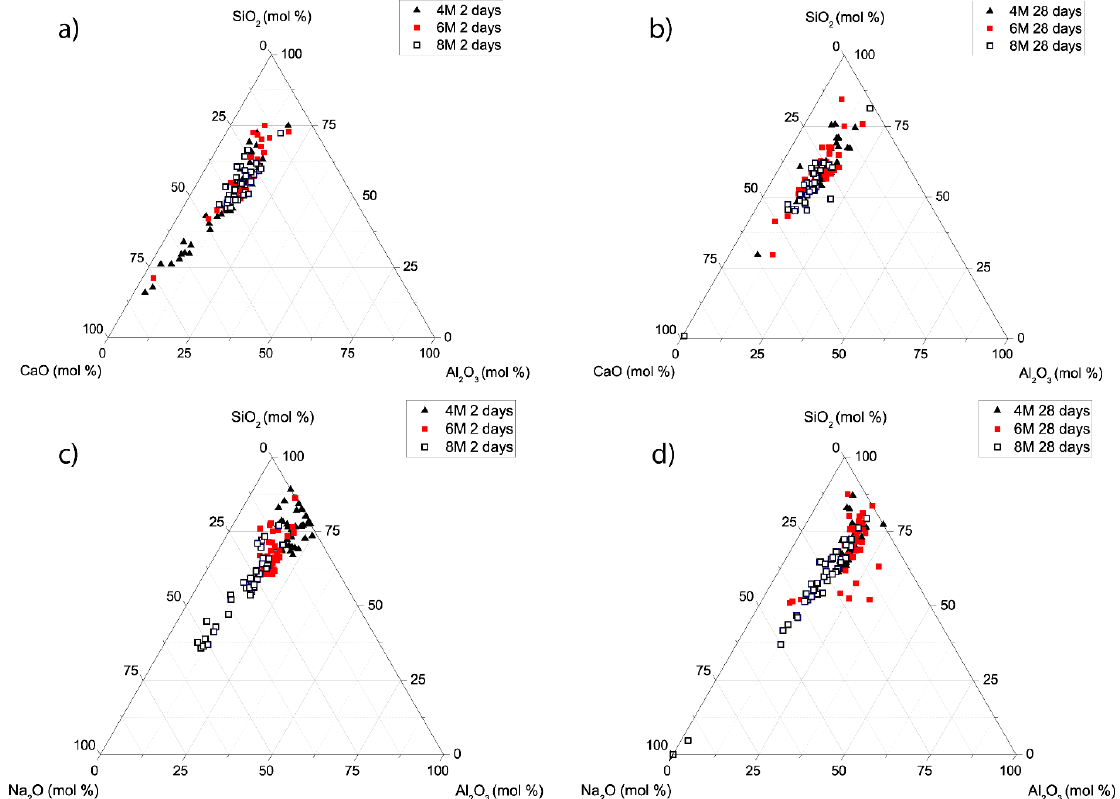
Figure 7. EDX data for the two and 28 days, 4, 6 and 8 M NaOH-activated pastes graphed on ( a , b ) CaO-Al 2 O 3 -SiO 2 ; and ( c , d ) Na 2 O-Al 2 O 3 -SiO 2 ternary diagrams.